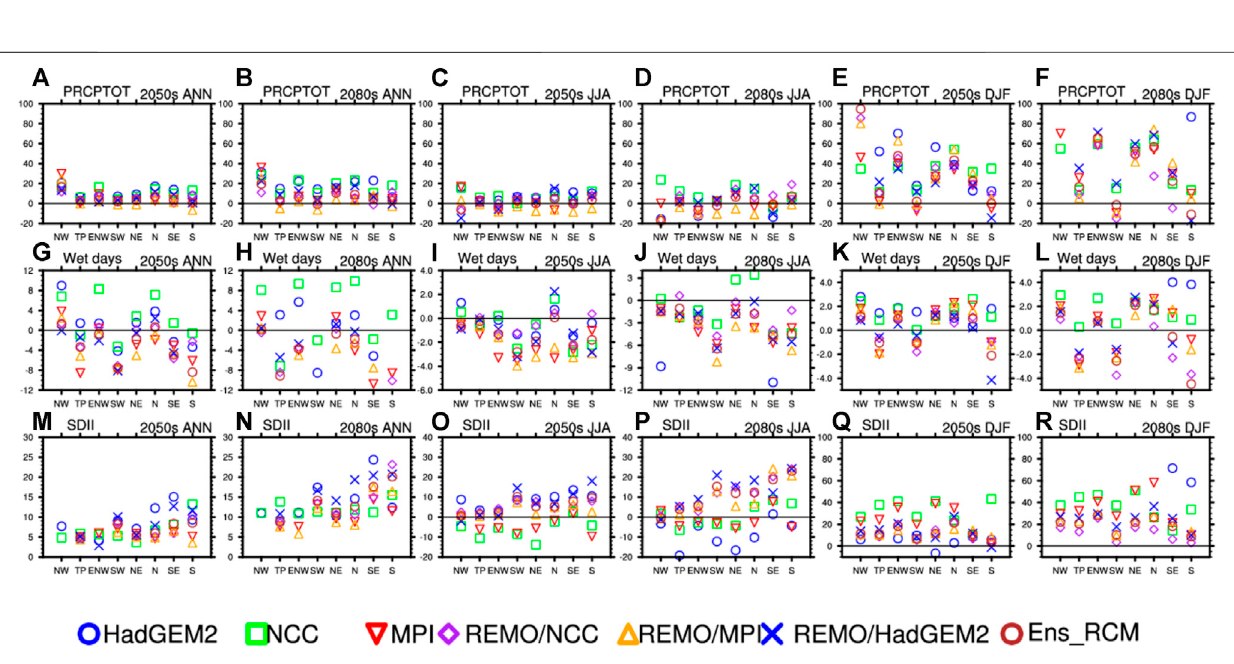
Frontiers in Earth Science |